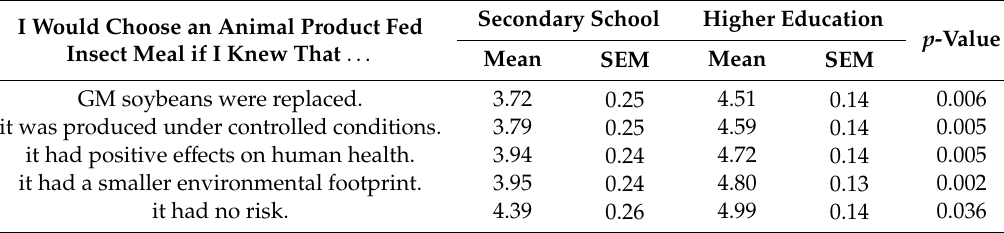
Table 6. Factors influencing the acceptance of a product that originated from an animal fed with insect meal, depending on educational background (on a 1–7